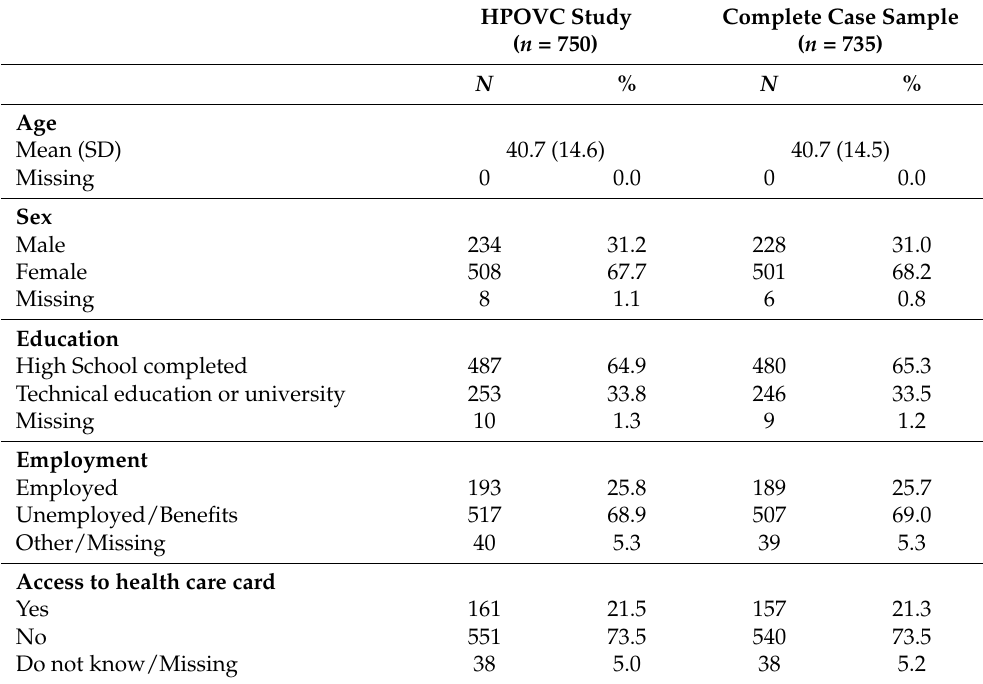
Table 1. Characteristics of study